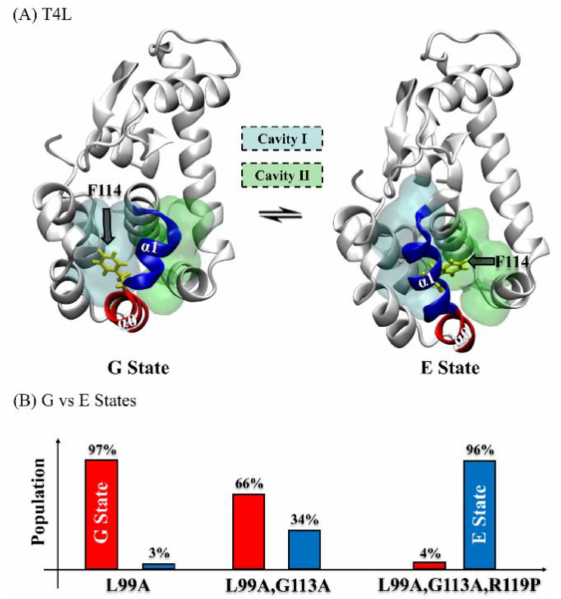
Figure 1. ( A ) The overall structures of the ground state (G state) [14] and the excited state (E state) [15] for T4 lysozyme, with the two hydrophobic cavities shown: Cavity I (formed by M102/M106/L133/W138, cyan) and Cavity II (formed by L84/V87/A99/V103, green). The G/E interconversion mainly involves the flipping of F114 (yellow) and the rearrangement of helices α 0 (red, G state: residues 114 to 122; E state: residues 119 to 122) and α 1 (blue, G state: residues 107 to 113; E state: residues 107 to 118). ( B ) The relative fractional population between the G state (red) and the E state (blue) was modulated by different mutants